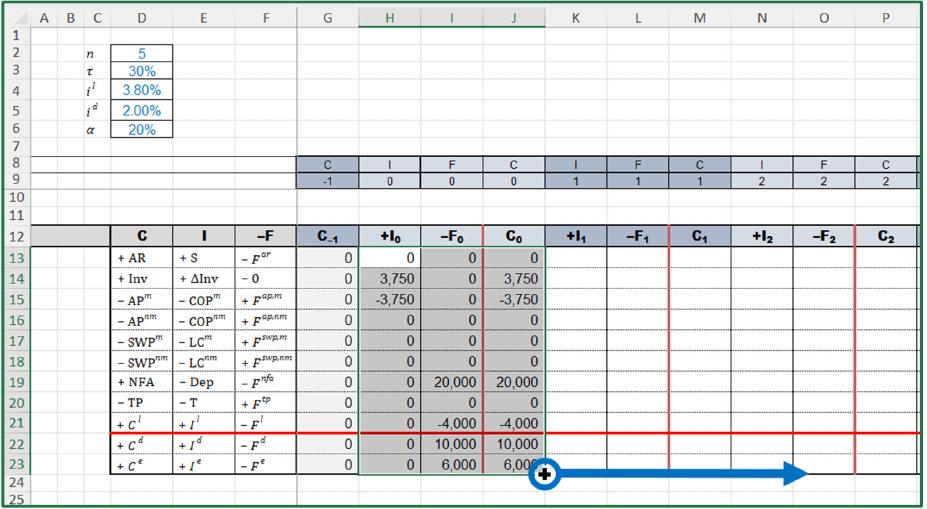
Figure 22. Drag the fill handle to fill the strip (“SplitScreenStrip” sheet).